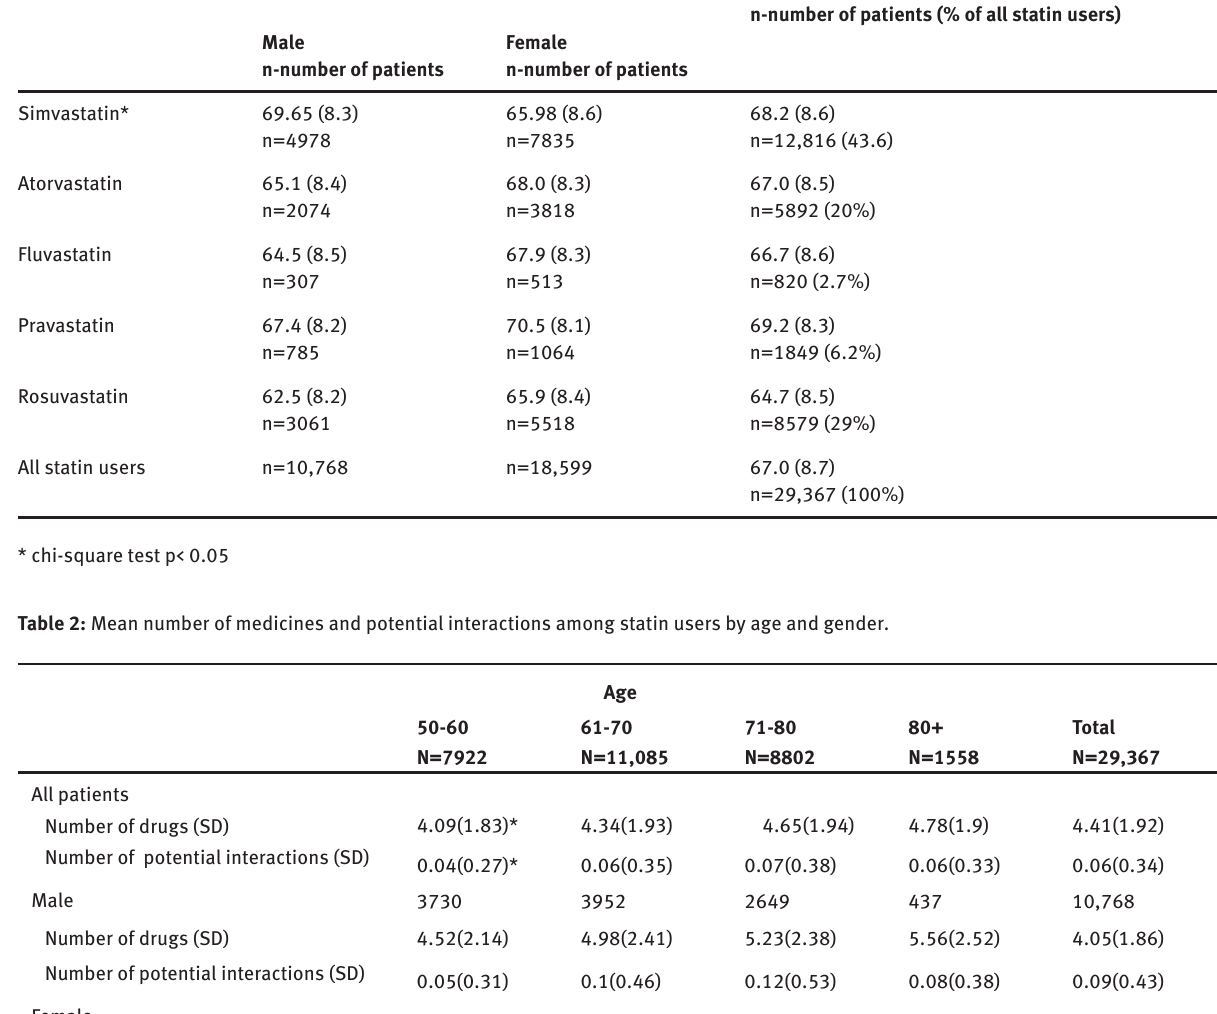
Table 1: Mean age of users of different statins Statin